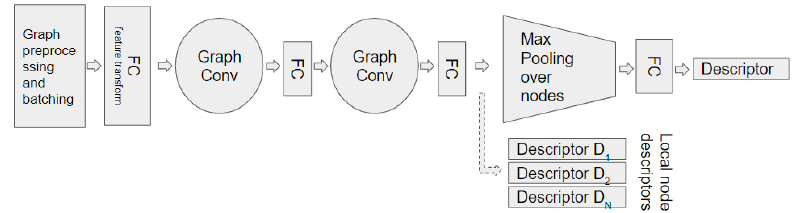
Figure 3. Schematic architecture of the model proposed to train the graph